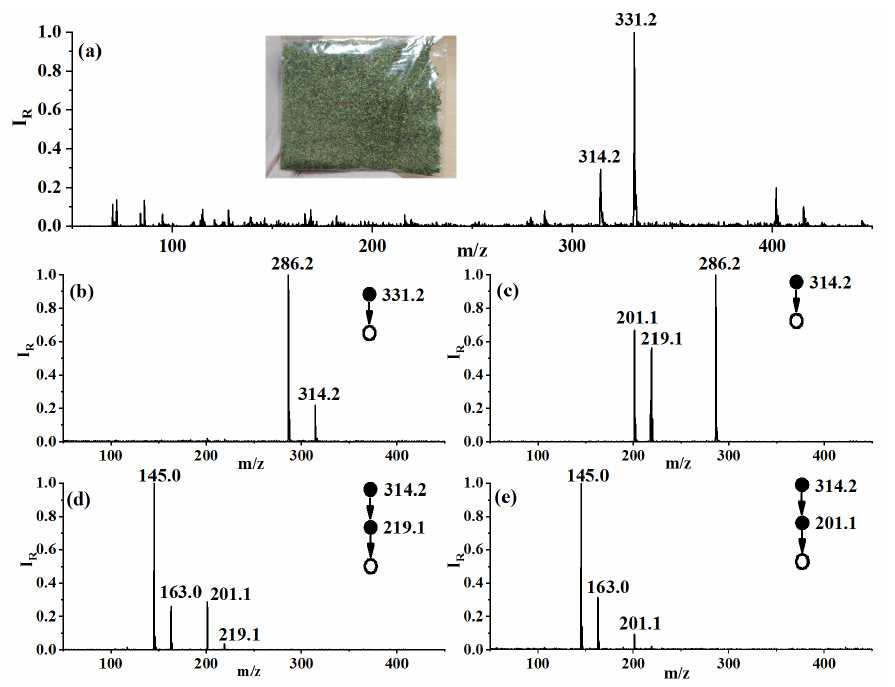
Figure 5. Spectra of a suspicious real-world sample using the DLIT-MS. ( a ) Full scan mass spectrum; ( b , c ) MS/MS spectra; ( d , e ) MS/MS/MS spectra.